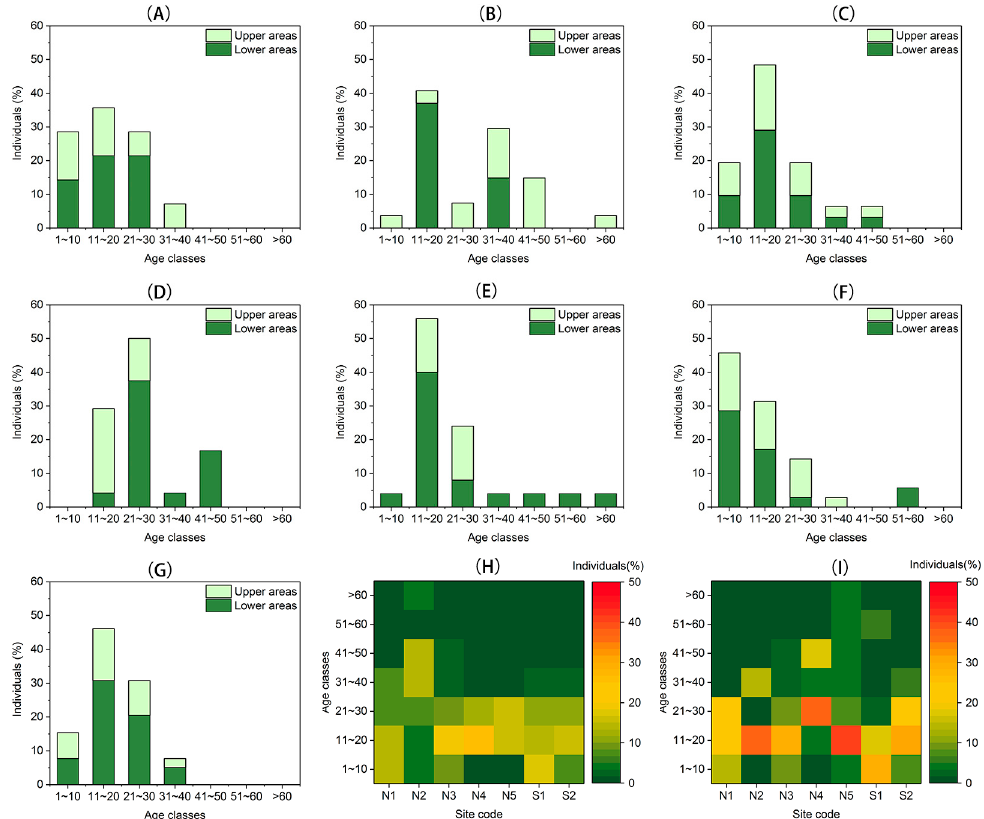
Figure 5. Age structure (10-year interval) of Larix in the alpine treeline ecotone in the eastern Tibetan Plateau during the period of 1971–2014. Seven green bar charts (from Figure 5A–G) show the age structure of Larix in the upper and lower areas within each sampling site (( A ): site N1; ( B ): site N2; ( C ): site N3; ( D ): site N4; ( E ): site N5; ( F ): site S1; and ( G ): site S2). Heat maps (Figure 5H,I) at the right bottom show the differences of age structure in upper and lower areas in different sites (( H ): upper areas; and ( I ): Lower areas). The colors from green to red represent lower and higher proportions.